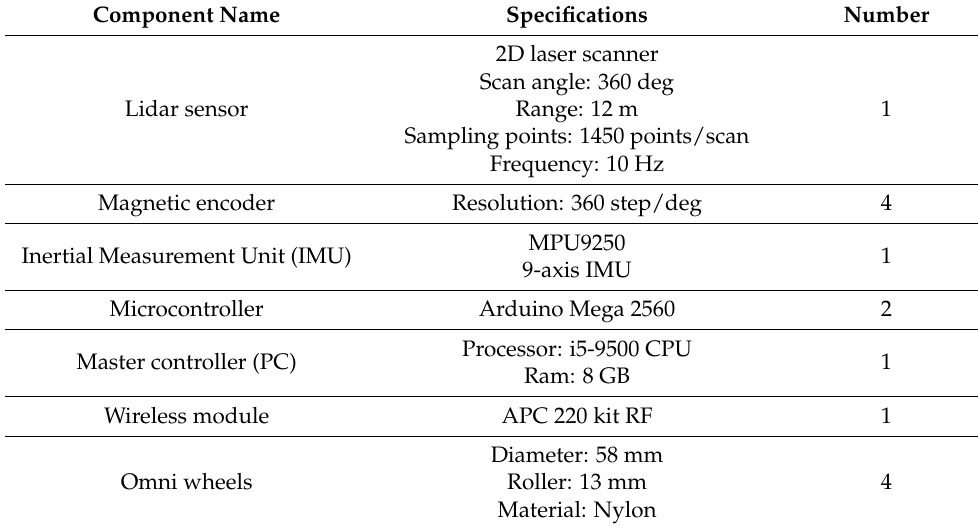
Table 2. Main hardware components of the omni-wheeled mobile robot